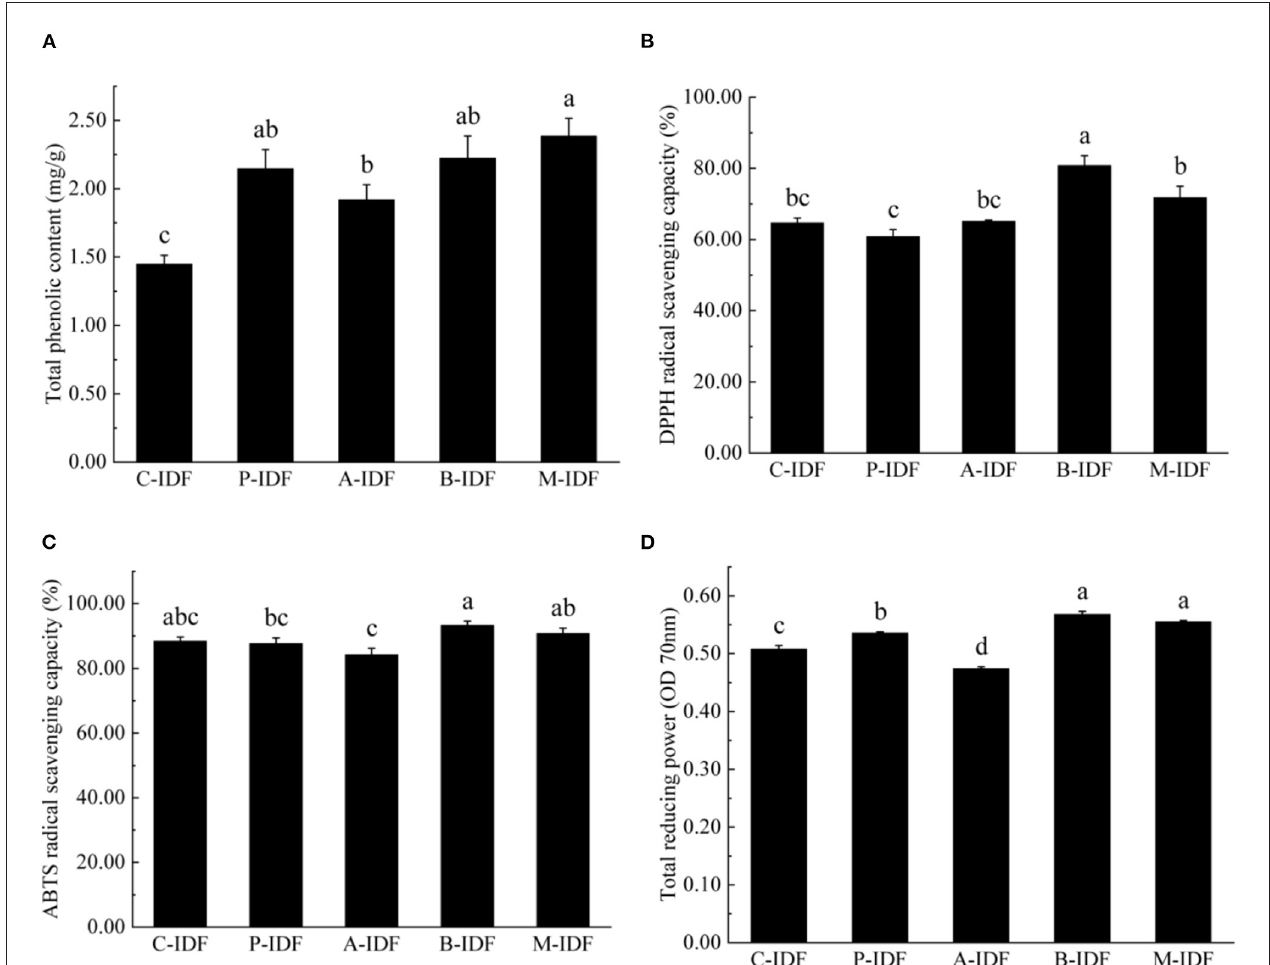
FIGURE 6 | Antioxidant activity of W-IDF. (A) Total phenolic content (TPC), (B) DPPH radical scavenging capacity, (C) ABTS radical scavenging capacity, (D) total reducing power. Data were expressed as means ± SD with different letters representing significant difference ( p <